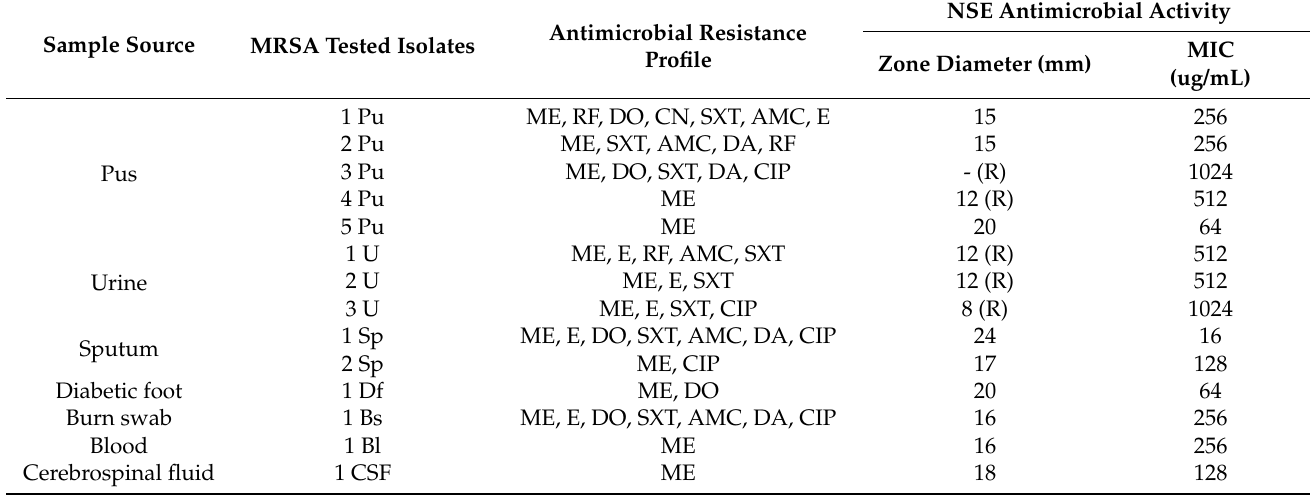
Table 4. Antibacterial activity of NSE against resistant MRSA isolates from human clinical samples.